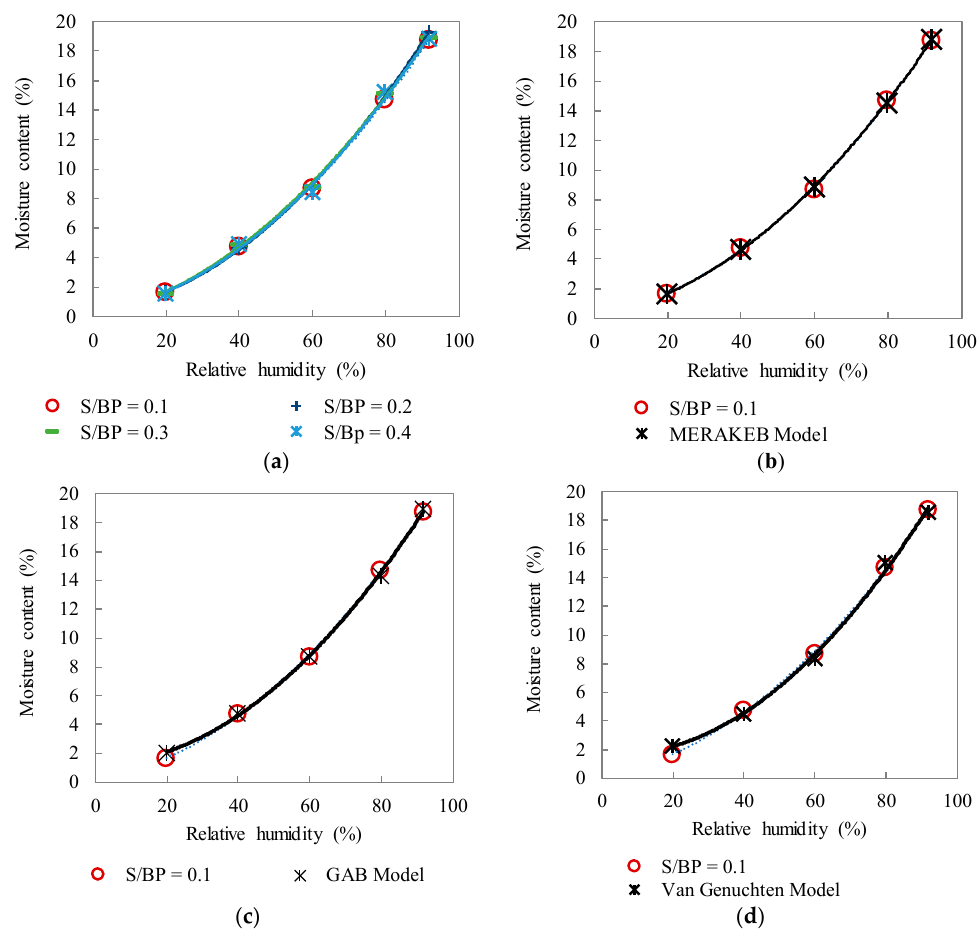
Figure 14. ( a ) Sorption isotherms of S–BP composites for the four formulations and the comparison of the experimental data with Merakeb ( b ), GAB ( c ), and Van Genuchten ( d ) models. Table 5. Parameter values for the sorption isotherm models.